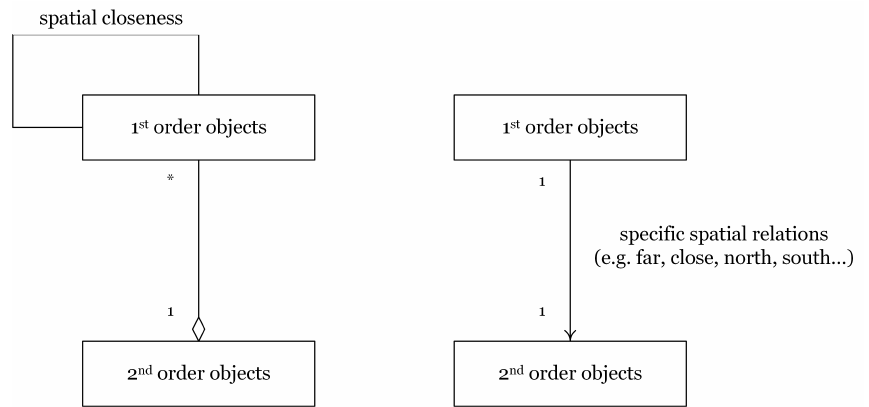
Figure 7. Difference between ECOs ( left ) and OROs ( right ), represented by UML class